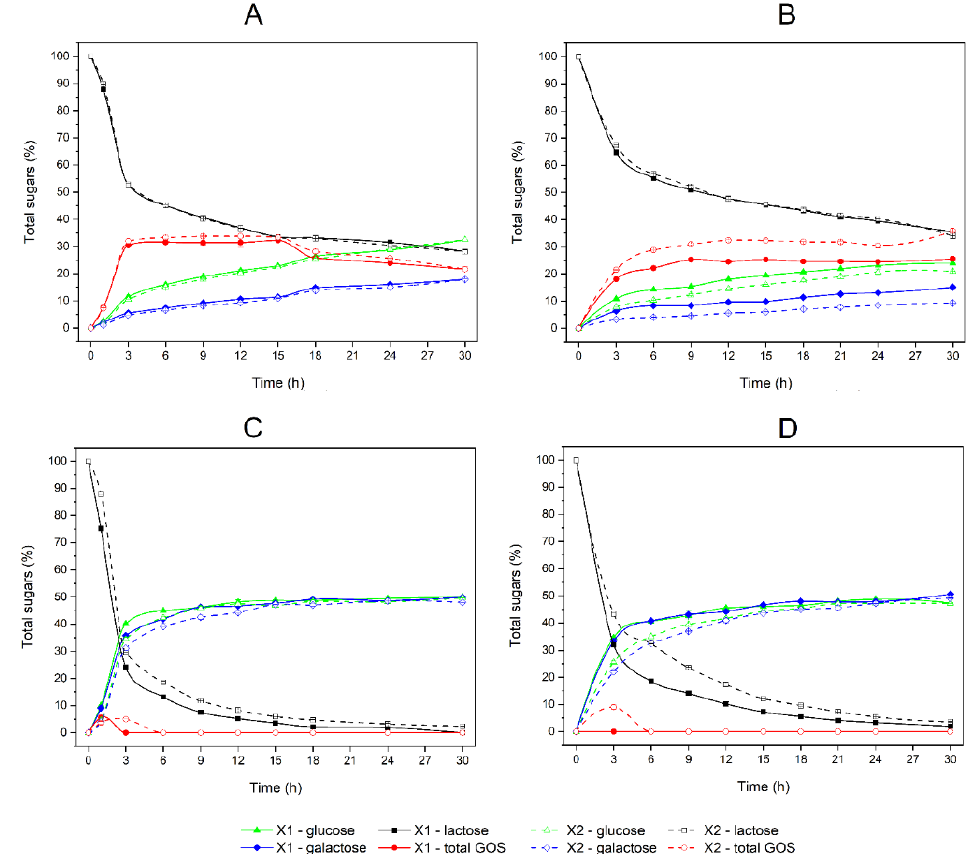
Figure 7. Reaction kinetics of lactose hydrolysis and GOS formation catalyzed by β -galactosidase entrapped in the PDMS-modified composite X1 (solid lines) and non-modified composite X2 (dashed lines): ( A ) hydrolysis of 250 g/L lactose at pH 4.5 and 55 ◦ C; ( B ) hydrolysis of 250 g/L lactose at pH 4.5 and 30 ◦ C; ( C ) hydrolysis of 50 g/L lactose at pH 4.5 and 55 ◦ C; ( D ) hydrolysis of 50 g/L lactose at pH 4.5 and 30 ◦ C. The data shown are the means of two independent experiments ± standard deviations. Black squares represent data for lactose content (%); green triangles represent data for glucose content (%); blue diamonds represent data for galactose content (%); and red circles represent data for total galactooligosaccharides (GOS) content